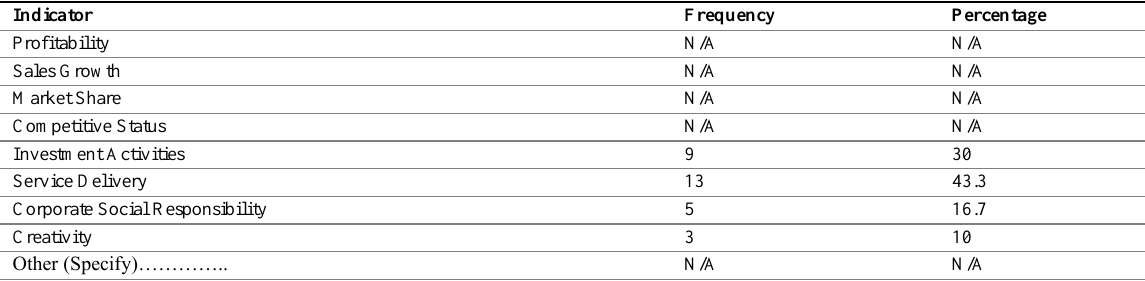
Table 1: Measures Determining NSSA’s